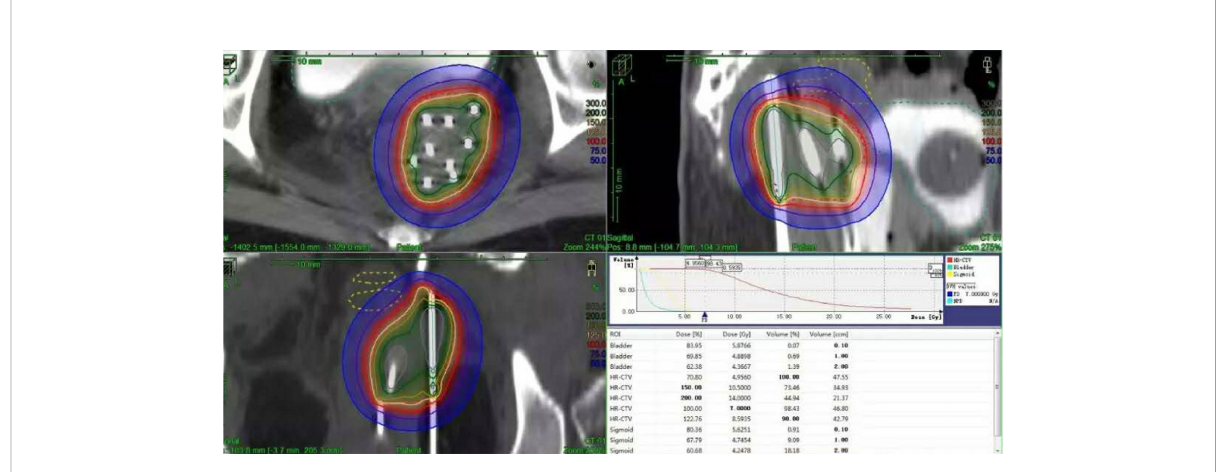
FIGURE 2 Distribution of needles and dose